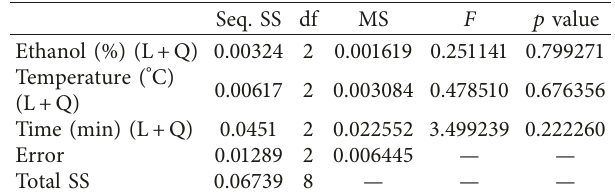
Table 2: Analysis of variance (ANOVA) of the regression pa- rameters for the Box–Behnken design used to determine the effect of ethanol, temperature, and time on the enzymatic activity of permeabilized cells of Aspergillus orzyae CCT